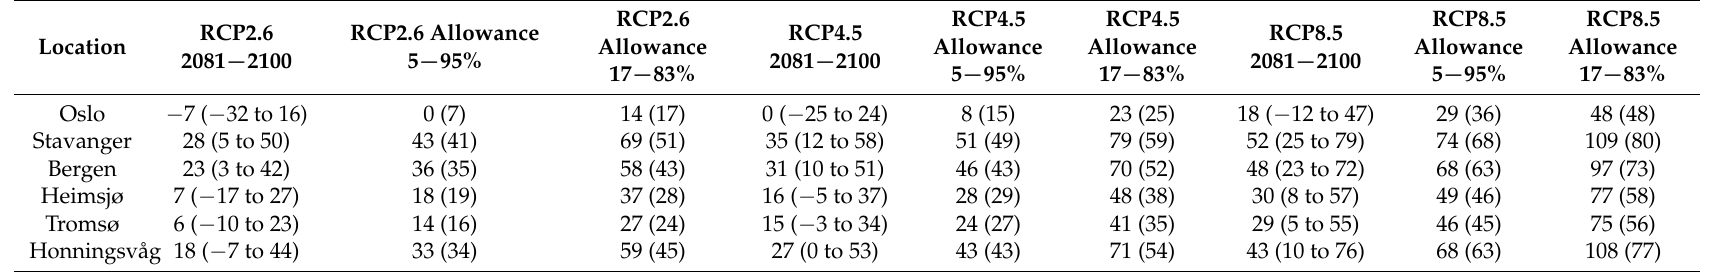
Table 5. Allowances (in cm) calculated for six key locations using the 1000-year return heights and projected ensemble mean RSL change over the period 1986–2005 to 2081–2100 (the 5% to 95% ensemble spread is given in parentheses). Allowances are given for two different choices of the level of likelihood assigned to the ensemble spread. The parentheses next to the allowances give the value of the standard error above the ensemble mean projected